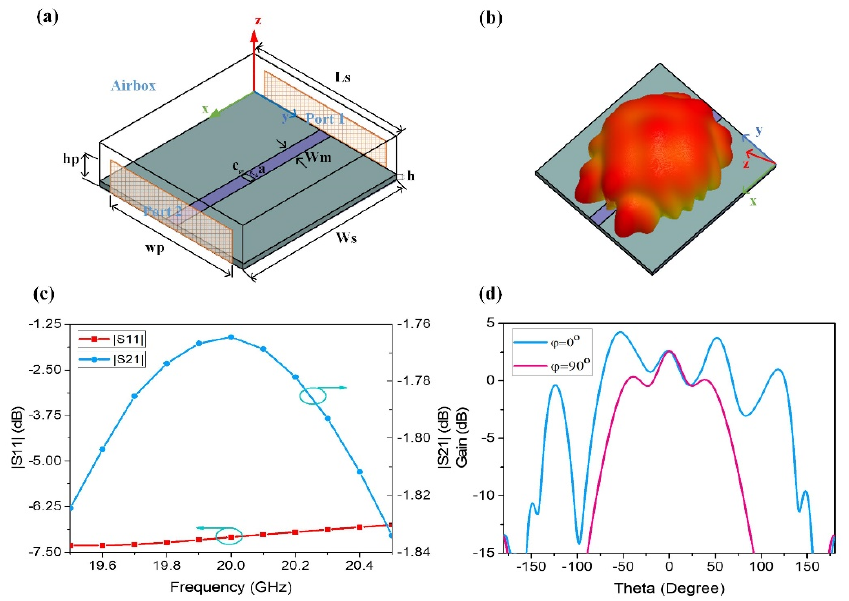
Figure 2. The model and simulation results. ( a ) The simulation model of a slot unit; ( b ) 3D radiation pattern of the unit model. ( c ) Scattering parameters ( | S 11 | , | S 21 | ) of the model; ( d ) The simulated pattern of the unit model. ( c ) Scattering parameters ( far-field radiation patterns of the unit cell on the planes of ϕ = 0 ◦ and ϕ = 90 ◦ , far-field radiation patterns of the unit cell on the planes of